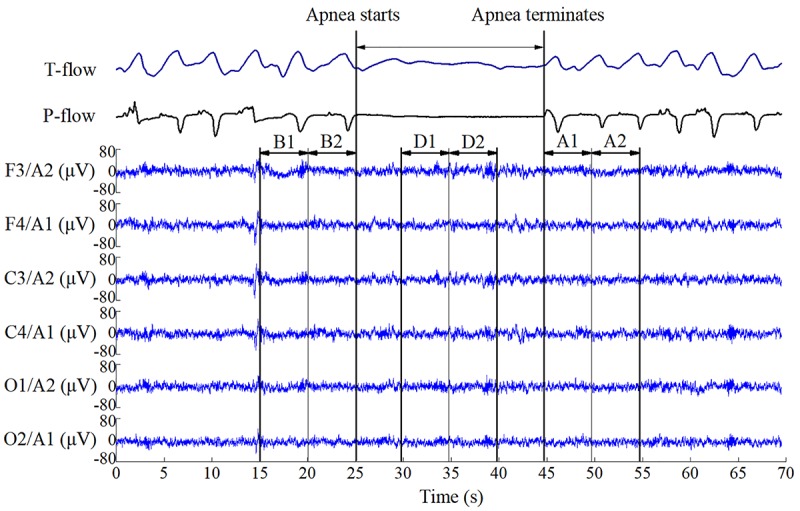
Electroencephalography data segments used for event analysis. B1 and B2 indicate segments before respiratory apnea–hypopnea events; D1 and D2 indicate segments during apnea–hypopnea events; A1 and A2 indicate segments immediately after apnea–hypopnea termination. The duration of each segment is 5 s.